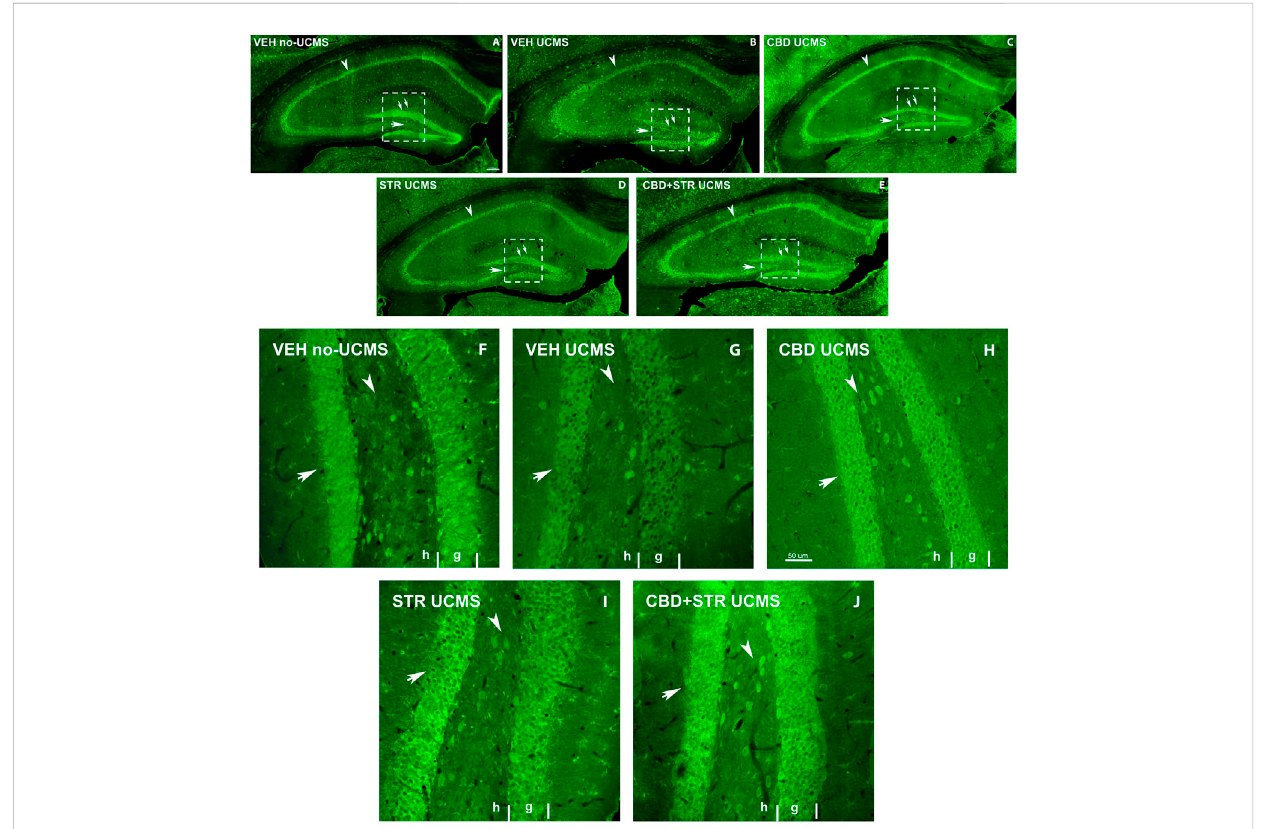
FIGURE 7 Low magni fi cation confocal images of BDNF-immunolabeling in mice exposed to the UCMS and treated with CBD, STR or their combination . Collages of confocal photomicrographs showing BDNF-ir (green labeling; A – E ) in the hippocampus of VEH-treated non-UCMS (A) , VEH-treated UCMS (B) , CBD-treated UCMS (C) , STR-treated UCMS (D) and CBD + STR treated UCMS (E) in adults ’ mice. Note the decrease in the number and labeling of BDNF-incellsinthepyramidallayerofCA1andCA3(arrowhead),thegranularlayer(doublearrow),andhilus(arrow)ofDGinVEH-treatedUCMS (B) compared with VEH-treated non UCMS (A) . These data show that BDNF-ir is recovered after treatment with CBD (C) , STR (D) , and CBD + STR (E) . The density and intensity of labeling are higher with CBD (C) and CBD + STR (E) treatment than with STR (D) alone in the pyramidal layer of CA1 and CA3 (arrowhead),thegranularlayer(doublearrow),andhilus(arrow)ofDG.Highmagni fi cationofDGofmiceexposedtotheUCMSandtreatedwithCBD,STR or their combination showed that the intensity of labeling is higher with CBD (H) and CBD + STR (J) treatments than with STR (I) (Arrows in (F – J) ). G: granular; H: